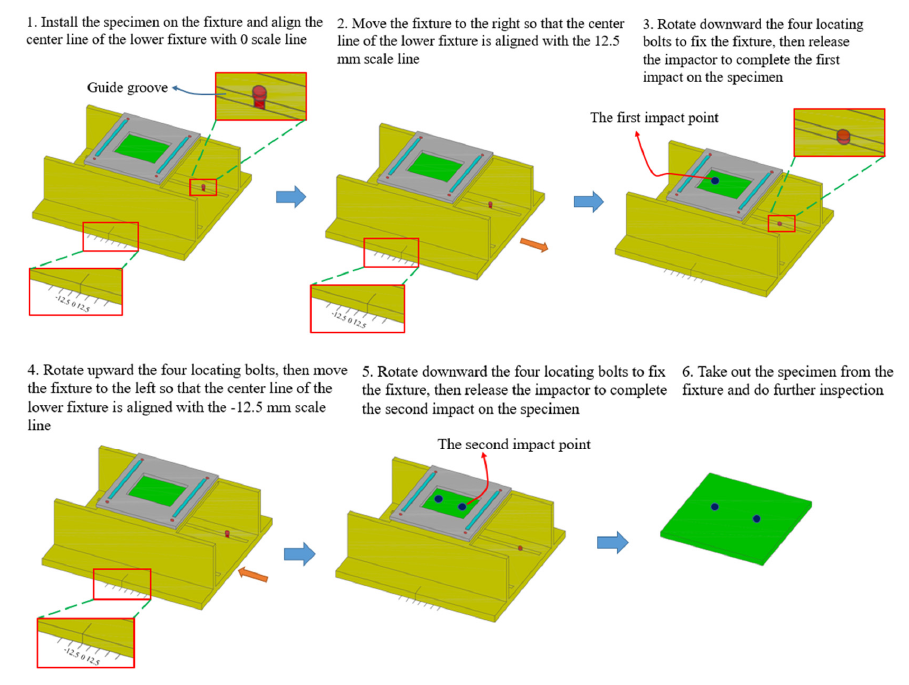
Figure 3. Low-velocity double-impacts test process.